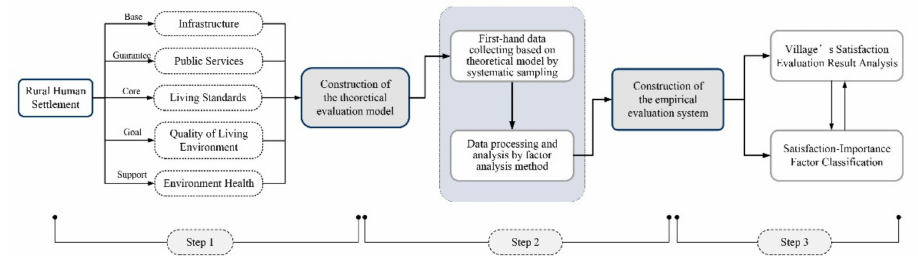
Figure 2. Framework on satisfaction evaluation of rural human